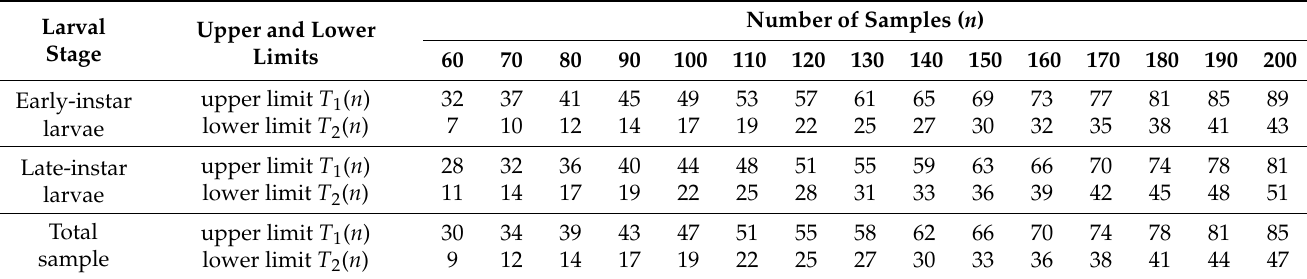
Table 5. The sequential sampling number of larvae of S. frugiperda in maize fields in 2020.